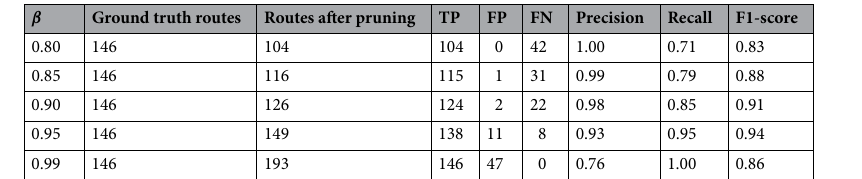
Table 3. Results for the triangle inequality pruned graph for the Central African Republic with 62 locations.